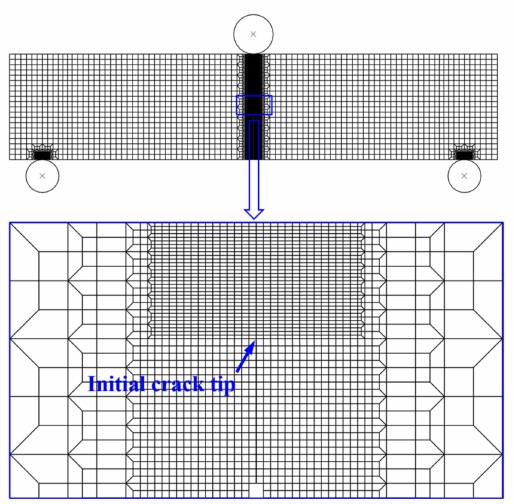
Figure 5. The finite element meshes of the typical designed crack-branching